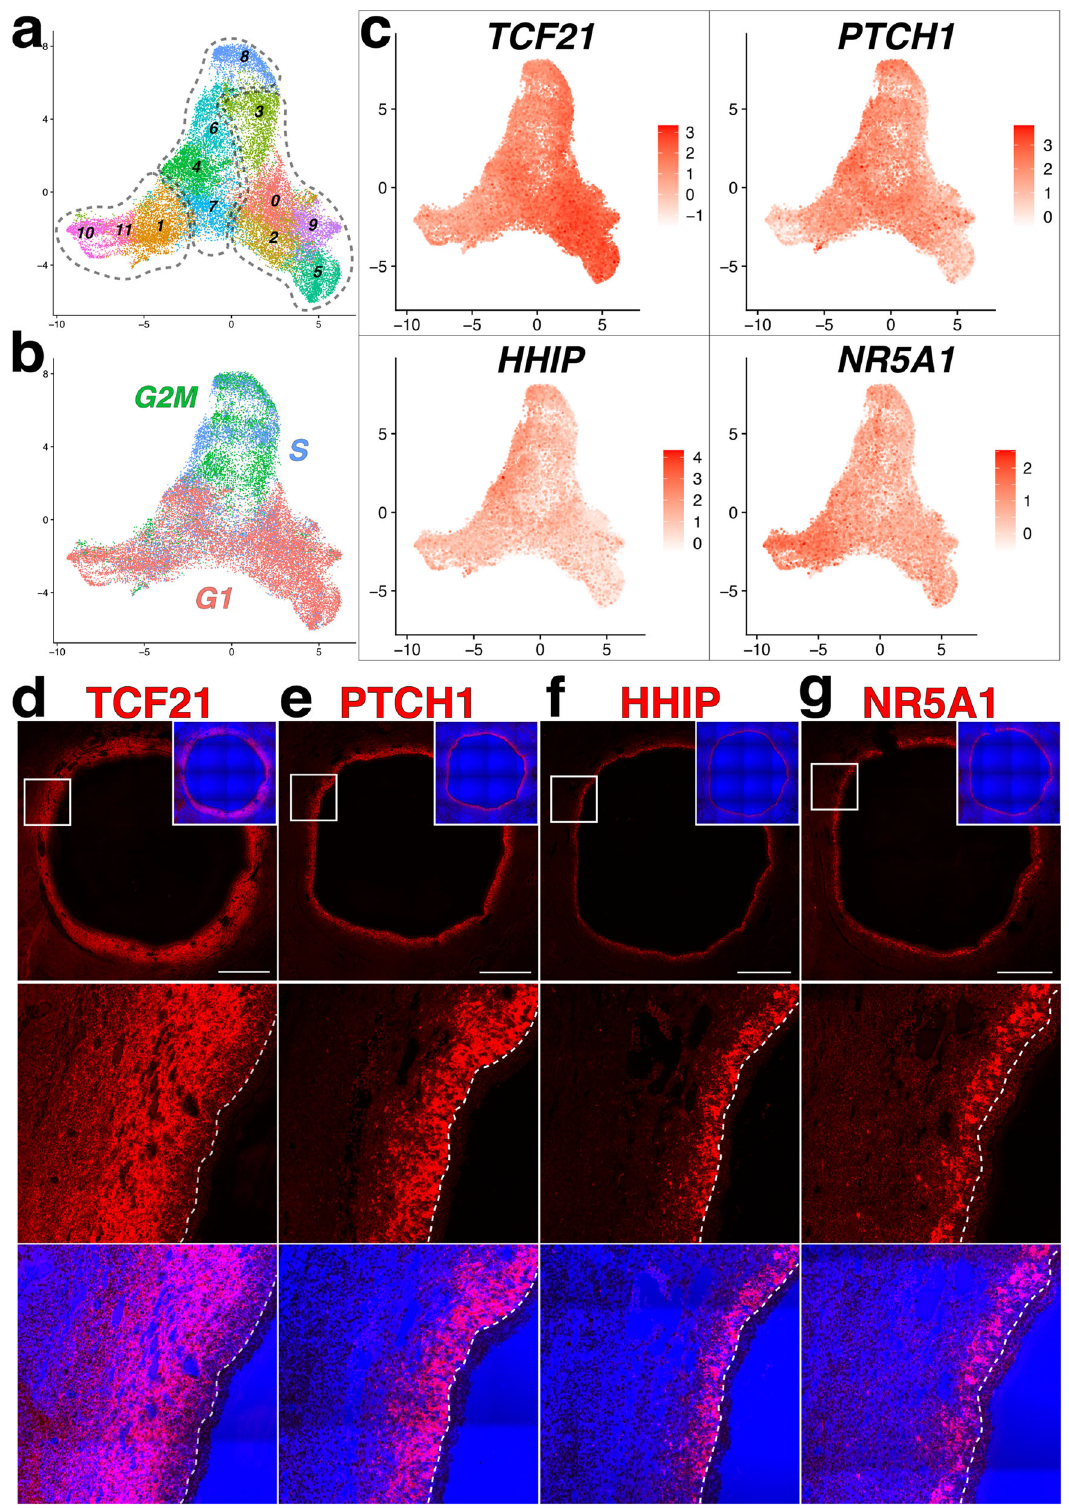
Fig. 1 Identi fi cation of theca/stroma sub-types by transcript expression within the theca/stroma layer. a – b UMAP plot of the isolated theca/stroma populations highlighting Seurat clusters ( a ) or populations colored by cell-cycle phase. G1 = pink, G2M = green and S = blue. c UMAP feature plots showing the expression of TCF21, PTCH1, HHIP and NR5A1 among theca/stroma cells. d – g RNA in situ hybridization signal for TCF21 ( d ), PTCH1 ( e ), HHIP ( f ), and NR5A1 ( g ) transcripts in antral follicles; probe signal is shown in red with the blue channel showing transmitted light. Magni fi ed views are denoted by white boxes. Scale bars – 1